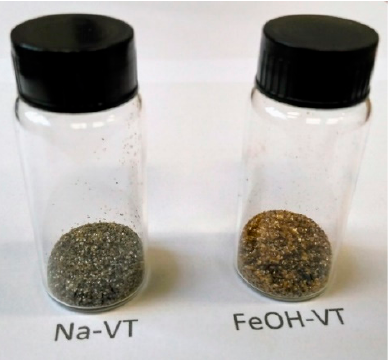
Figure 1 . View of the gray Na-Vt compared to the golden brown modified FeOH-Vt. Figure 1. View of the gray Na-Vt compared to the golden brown modified FeOH-Vt.